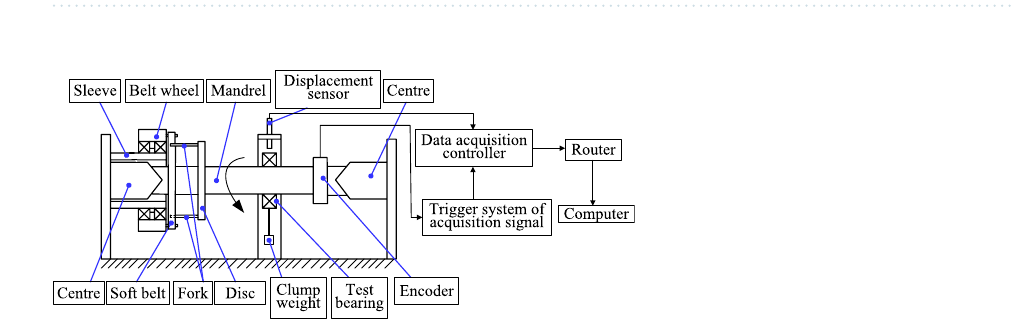
Figure 1. Geometric model of a bearing.